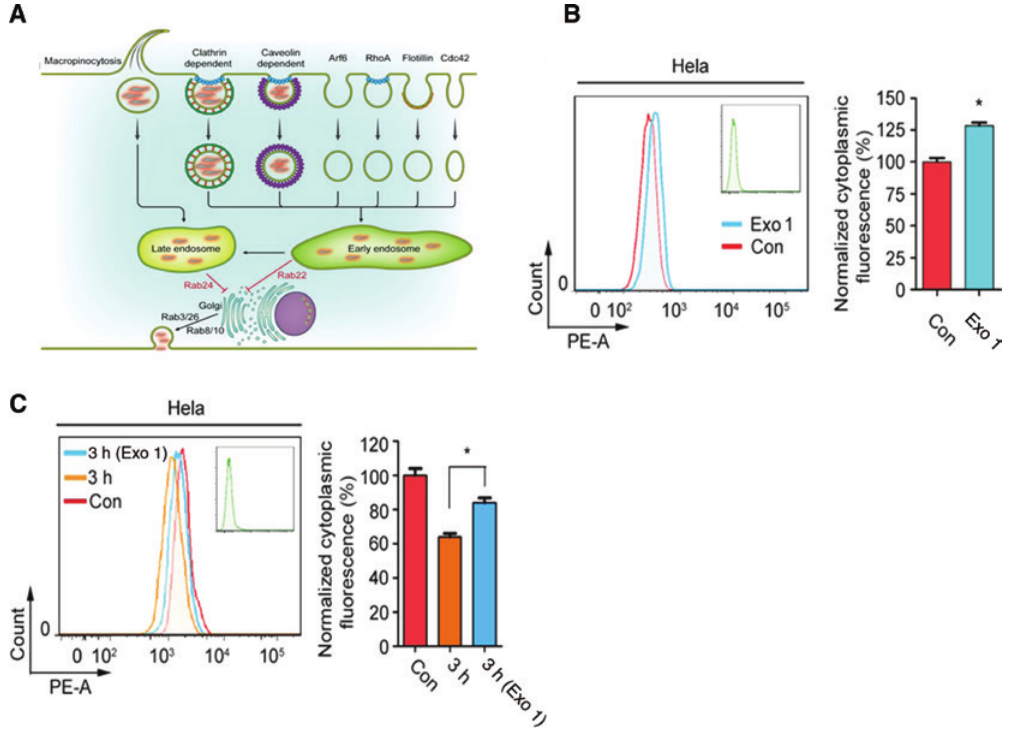
Figure 7: Increased accumulation of NSs within cells via exocytosis inhibition. (A) Schematic diagram of intracellular trafficking pathways of WS inhibitor Exo1 for 2 h, followed by another 3 h of incubation with WS fluorescence. (C) HeLa cells were first incubated with WS was refreshed and the cells were kept in the culture for another 3 h. Flow cytometry was used to quantify cytoplasmic